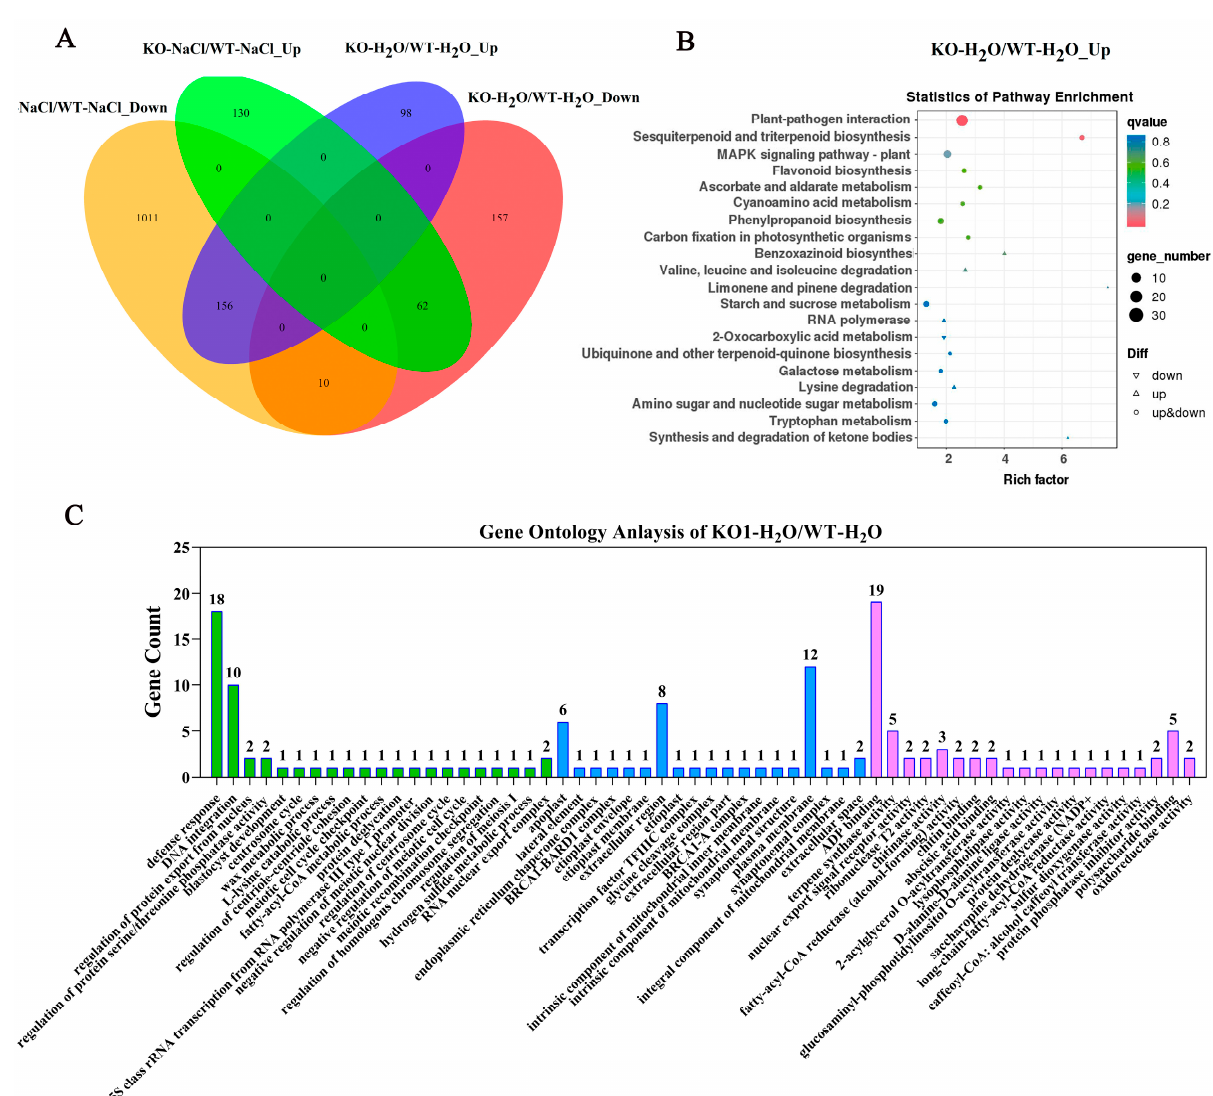
Figure 9. Results of GO and KEGG enrichment analyses of WT and KO1 plants under normal and salt stress conditions. ( A ) Venn diagram showing the overlap of DEGs identified in WT and KO1 seedlings under normal and salt stress conditions. KO-H 2 O/WT-H 2 O-Up/Down: DEGs up-regulated and down-regulated in KO1 plants compared with the WT under normal conditions; KO-NaCl/WT-NaCl-Up/Down: DEGs up-regulated and down-regulated in KO1 plants compared with the WT under salt stress conditions; ( B ) KEGG enrichment analysis of DEGs detected under normal conditions. ( C ) Functional annotation of genes differentially expressed between WT and KO1 plants with normal conditions. These genes were grouped into three categories: biological process ( green columns ), cellular component ( blue columns ), and molecular function ( purple columns ).